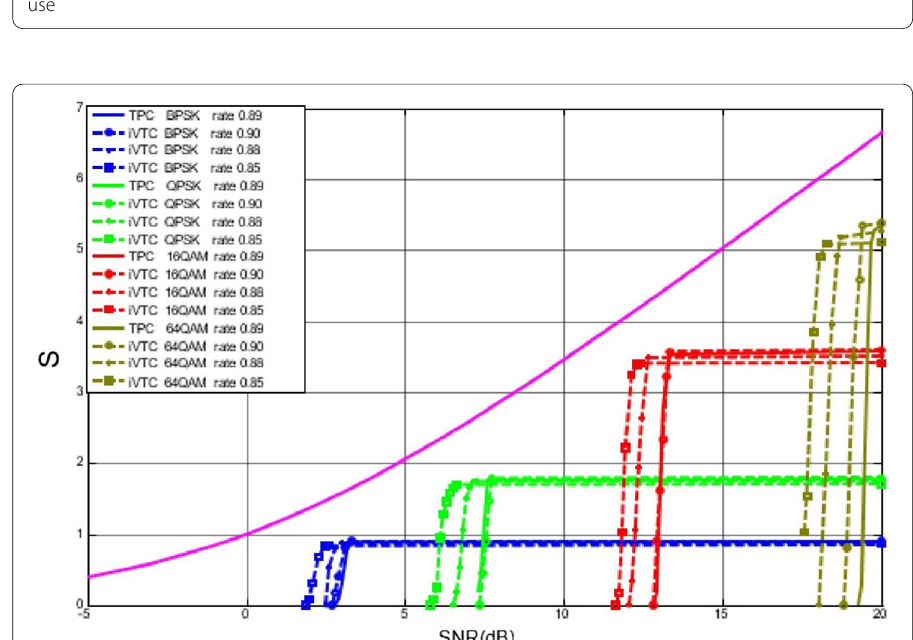
Fig. 7 (63, 57)TPC and equivalent iVTC throughput per channel use versus SNR. S represents bits/channel